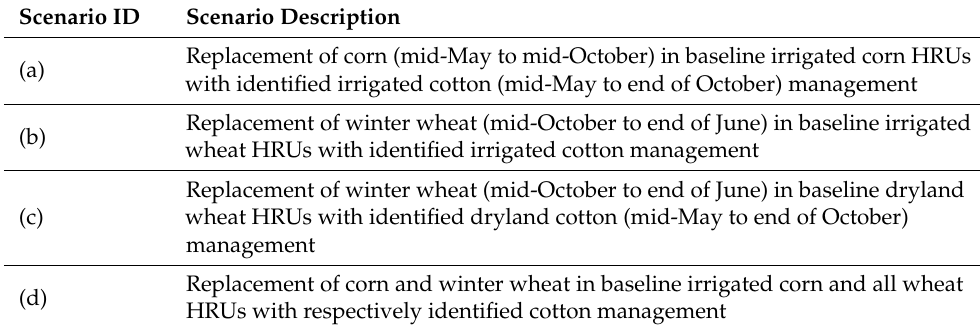
Table 2. Scenario design in the Palo Duro